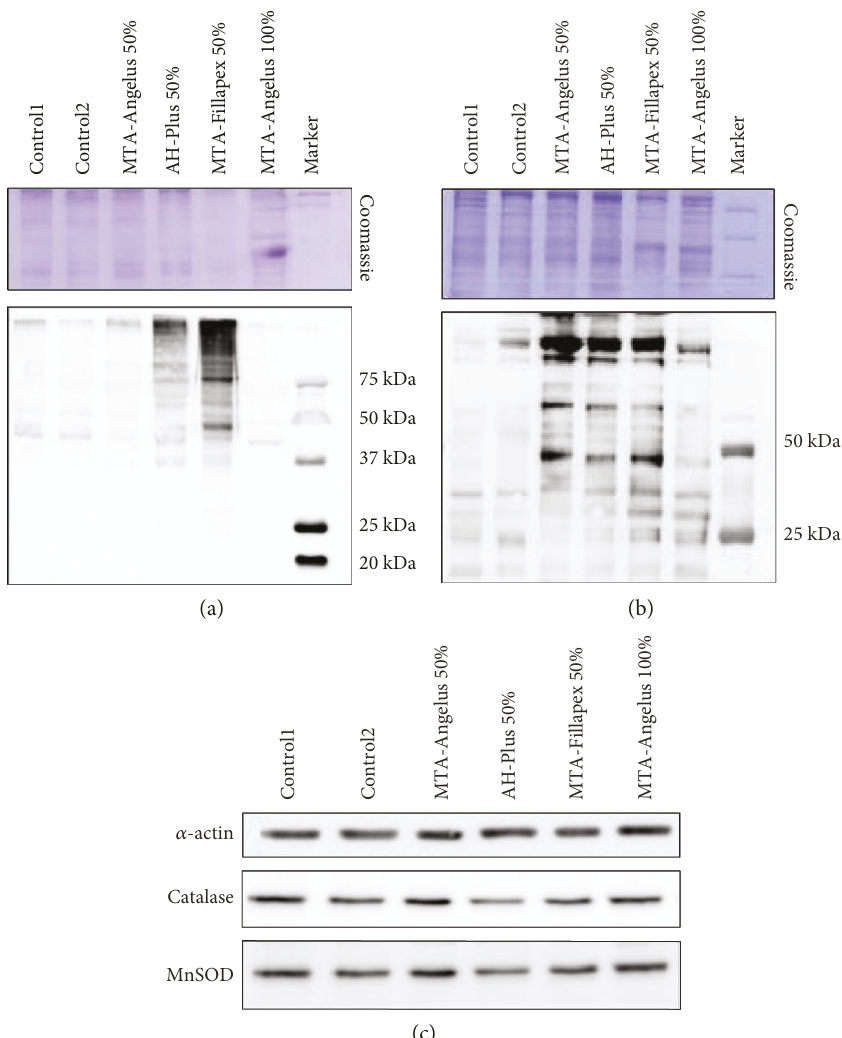
Figure 2: Oxidative stress and antioxidant responses in HDPSCs incubated with endodontic materials. Immunoblots are representative images of two independent analyses in HDPSCs incubated with MTA-Angelus, AH-Plus, and MTA-Fillapex. (a) OxyBlot analysis for the detection of carbonylated proteins from total extracts of HDPSCs incubated with endodontic materials for 24h. (b) OxyBlot analysis for the detection of carbonylated proteins from total extracts of HDPSCs incubated with endodontic materials for 7 days. (c) Western blot analysis of two antioxidant enzymes, catalase and MnSOD, from total extracts of HDPSCs incubated with endodontic materials for 24h. For OxyBlots, Coomassie gel staining was used as a loading control. In immunoassays for detecting the levels of antioxidant enzymes, β -actin was used as a reference and loading